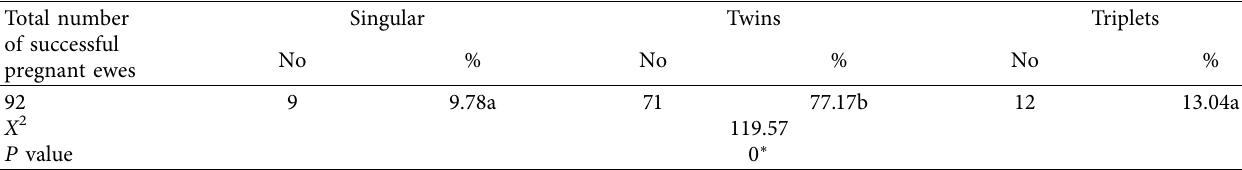
Table 2: Te numbers and percentages of singular, twins, and triplets lambs born of Awassi ewes impregnated with intravaginal progestin sponges along with eCG treatment.